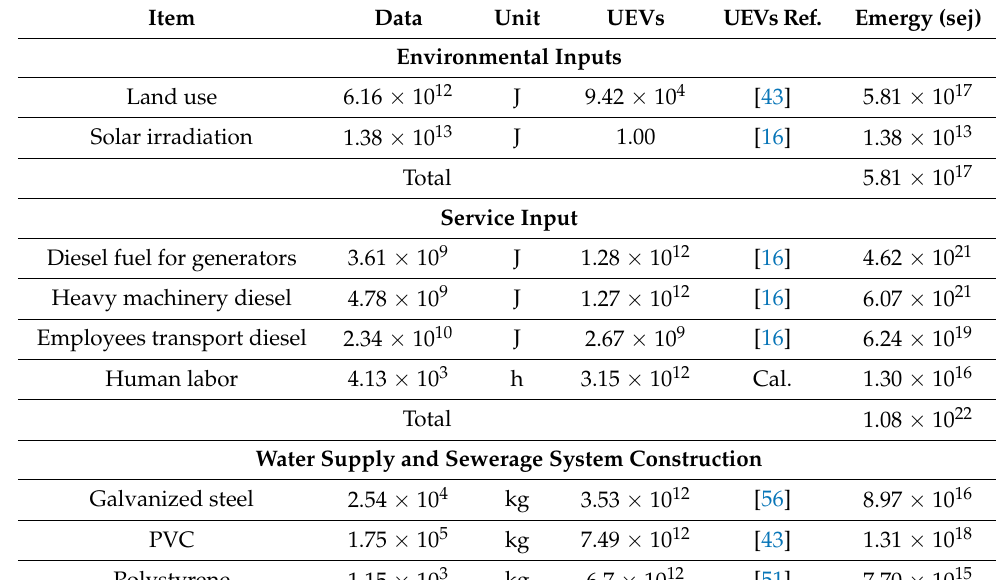
Table 3. Emergy table of Building construction